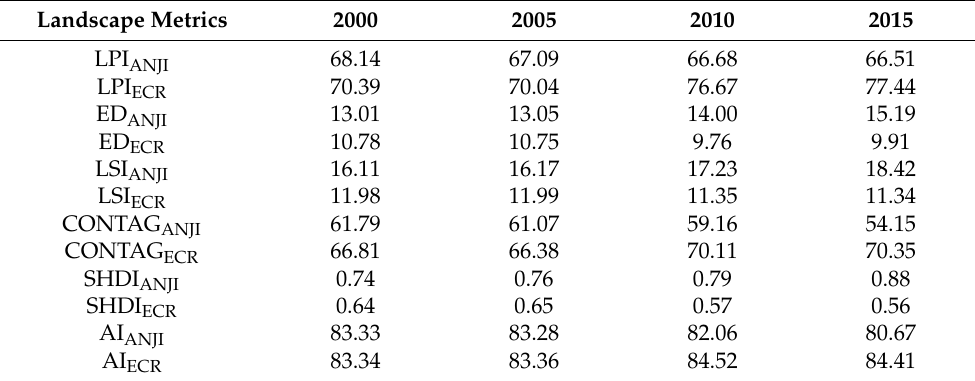
Table 3. Landscape metrics changes of the ECR areas and for the entire Anji County. Landscape